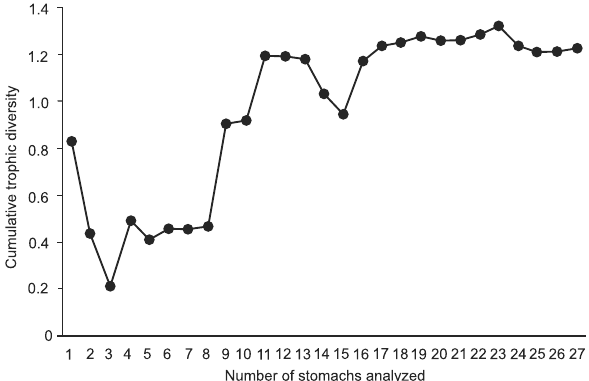
Figure 3. Cumulative trophic diversity of Netta peposaca in Santa Fe province,